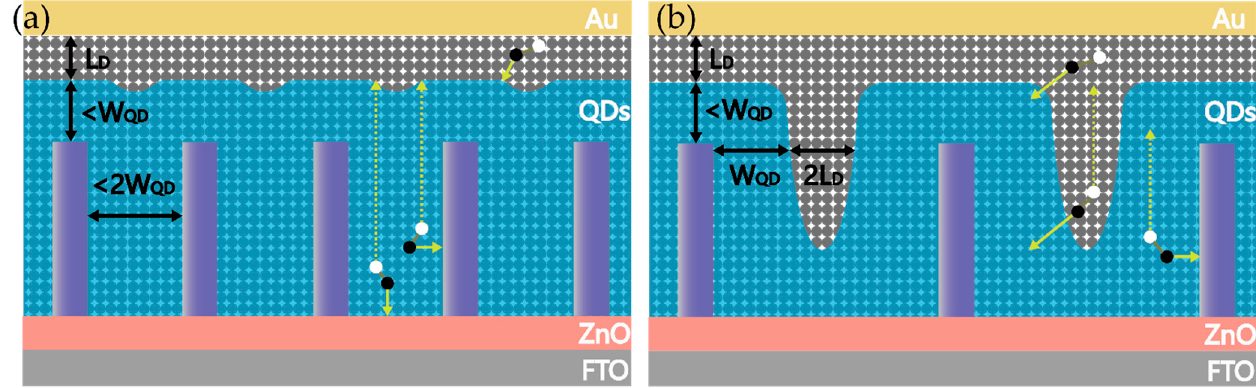
Figure 8. ( a ) IBHJ structure based on hydrothermal method; ( b ) ideal IBHJ structure. Table 3. Characteristic parameters of several lead chalcogenide QD material layers.